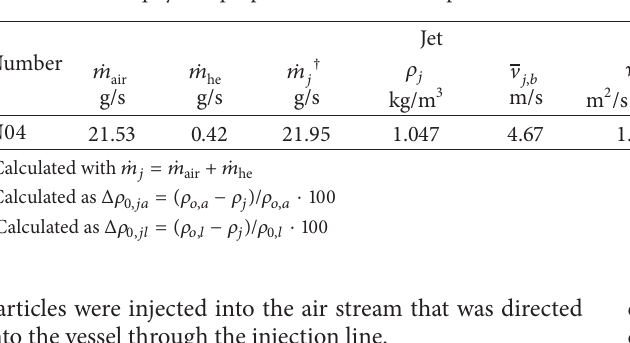
Table 1: Main measured parameters for the PANDA N04 experiment conducted in the frame of the OECD/NEA PANDA benchmark. For the calculation of physical properties a nominal temperature of 𝑇 = 22 ∘ C and the measured pressure of 𝑝 = 0.994 bar were